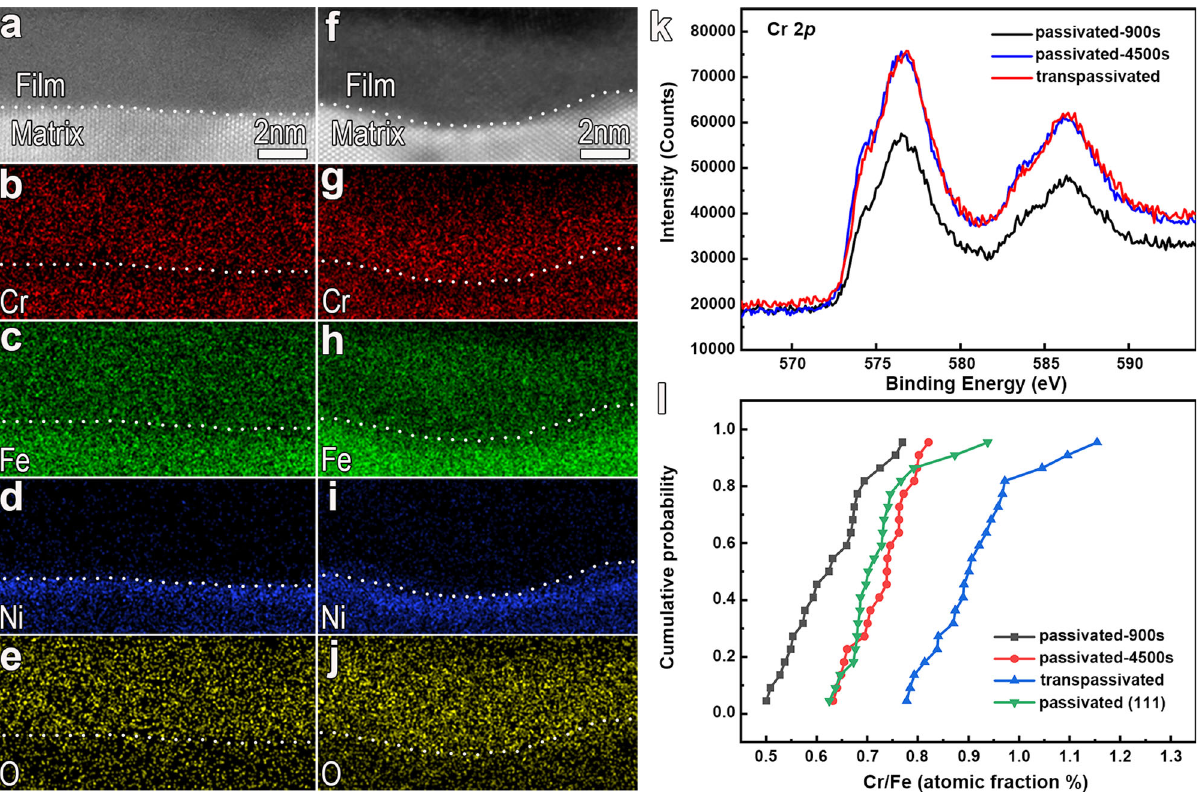
Fig. 6 Super-X EDS mapping in TEM and XPS analysis showing that transpassivation at 1.1 V/SCE induces an enhanced Cr-enrichment, while Cr valence is identical in the transpassive and passive fi lms. a – e High-resolution HAADF-STEM image of the passive fi lm ( a ) and the corresponding elemental maps ( b – e ). f – j High-resolution HAADF-STEM image of the transpassive fi lm ( f ) and the corresponding elemental maps ( g – j ). The passive fi lm was formed by potentiostatically polarizing at 0.4 V/SCE in 0.5 mol L − 1 H 2 SO 4 for 900 s; while transpassivation was accomplished subsequently at 1.1 V/ SCE for 3600 s. k XPS analysis showing Cr 2p spectral lines of the three types of fi lms. It is obvious that transpassivation does not induce Cr 2p peak displacement. l The cumulative probability analysis on Cr/Fe ratio con fi rms the enhanced enrichment of Cr induced by the transpassivation